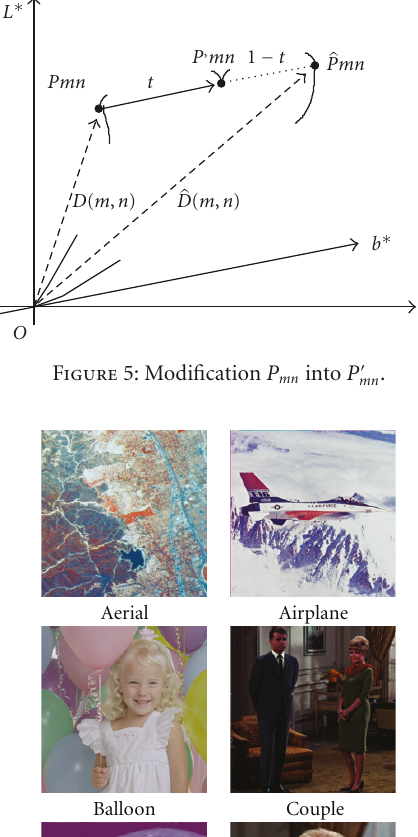
Figure 5: Modification P mn into P (cid:3)